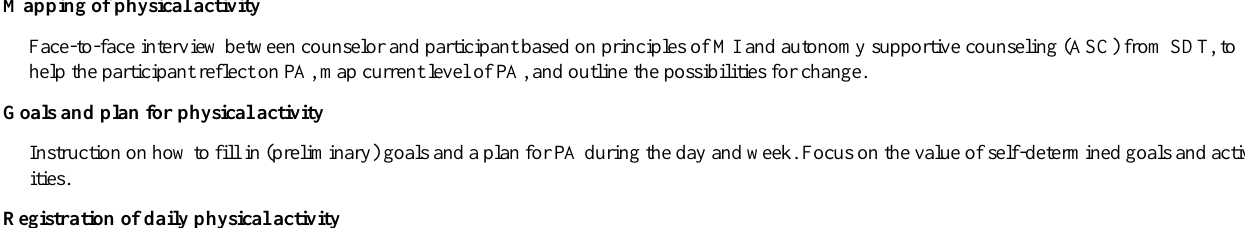
Table 2. Overview of planned content of Young & Active. Mapping of physical activity